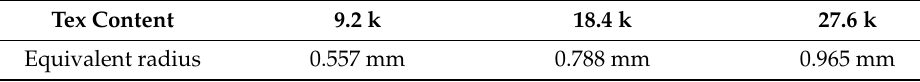
Table 3. Equivalent radius of fiber bundles with different Tex